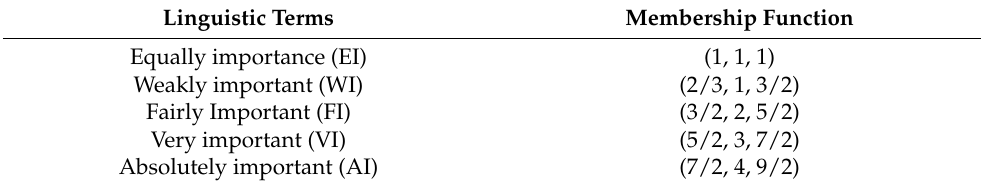
Table 1. Transformation rules of linguistic variables of decision